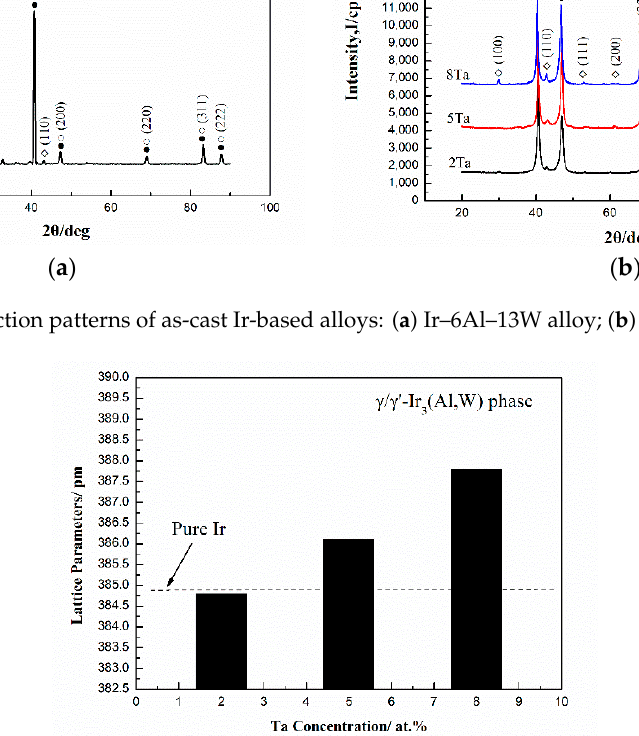
Figure 2. E ff ect of Ta on the lattice parameters of γ / γ (cid:48) two-phase Ir–6Al–13W Figure 2. Effect of Ta on the lattice parameters of γ / γ ’ two-phase Ir–6Al–13W alloys.